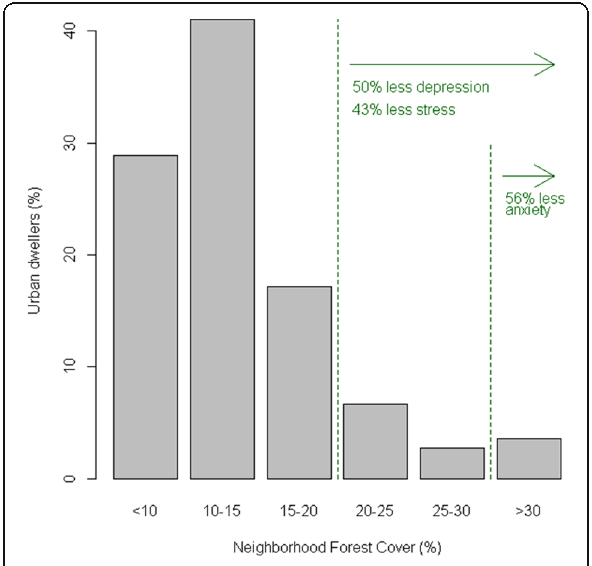
Fig. 5 Forest cover in urban neighborhoods and its impact on mental health. The bar chart shows the fraction of urban dwellers who live in neighborhoods with varying levels of forest cover. Forest cover was estimated for 1-km square neighborhoods in 245 major cities globally, as part of the Planting Healthy Air report [81]. The green lines shows thresholds in vegetative cover and its relationship to mental health, as identified by Cox et al. [102], who surveyed 263 respondents in three towns in the United Kingdom. They found that the odds-ratio of depression, stress, or anxiety being reported was significantly higher when houses had less than these thresholds of vegetative cover in the 250 m around their